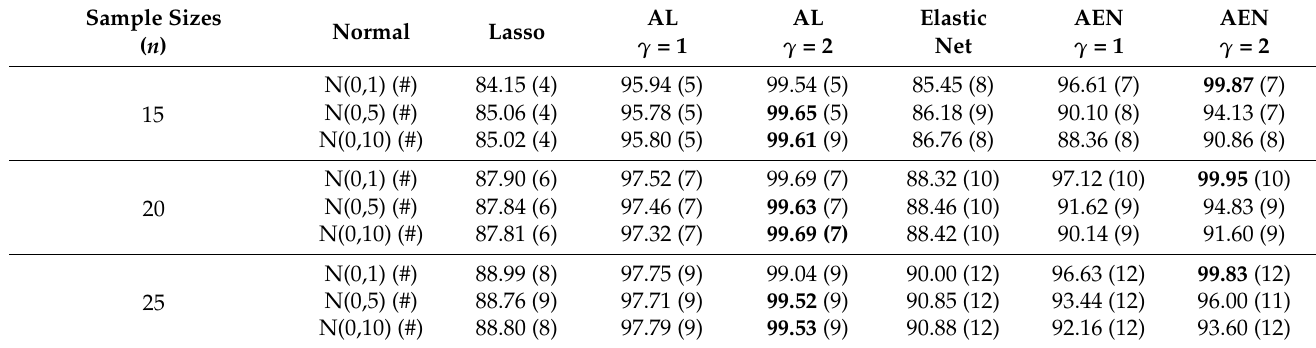
Table 3. The average percentage of accuracy and the average number of selected variables (#) of lasso, adaptive lasso (AL), elastic net, and adaptive elastic net (AEN) under 30